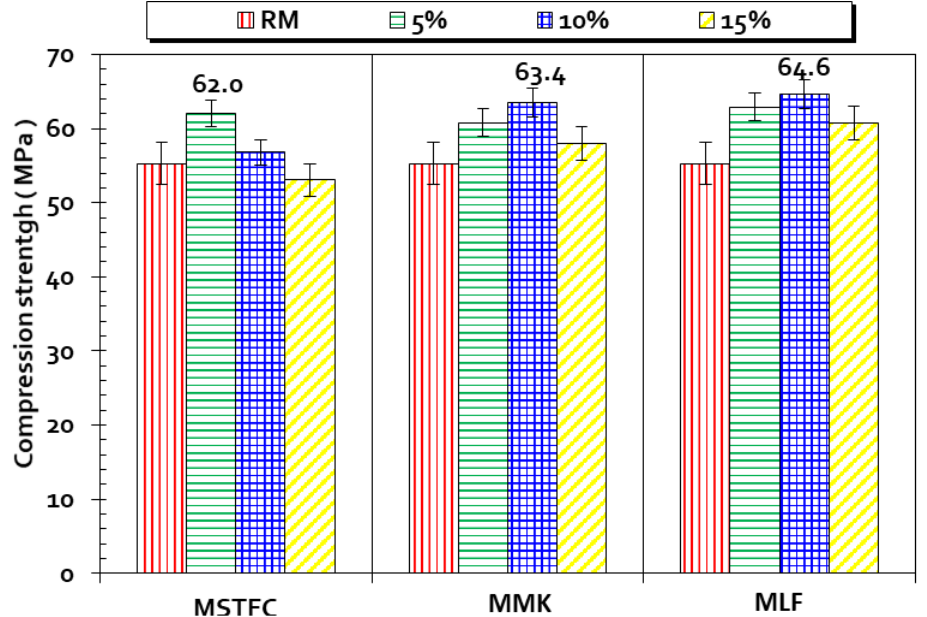
Figure 11. Compressive strength of MSTFC, MK and LF (5%, 10%, and 15%) mortars at 28 days maturation.